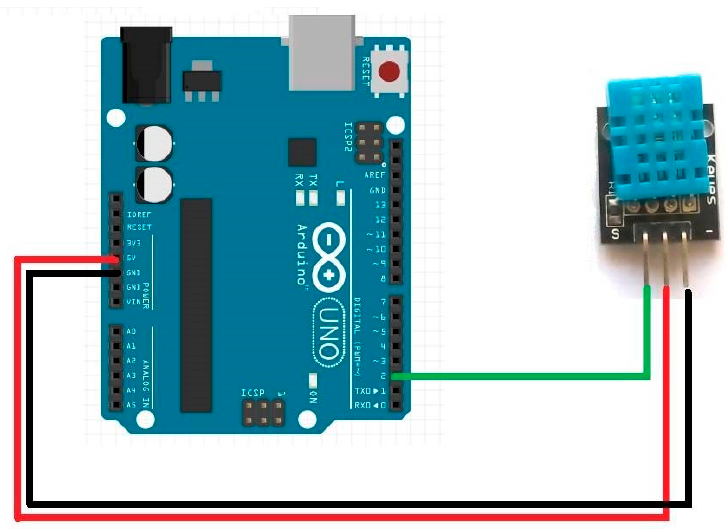
Figure A4. Pulmonary Circulation model’s circuit.